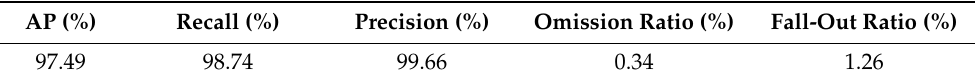
Table 5. Results after using